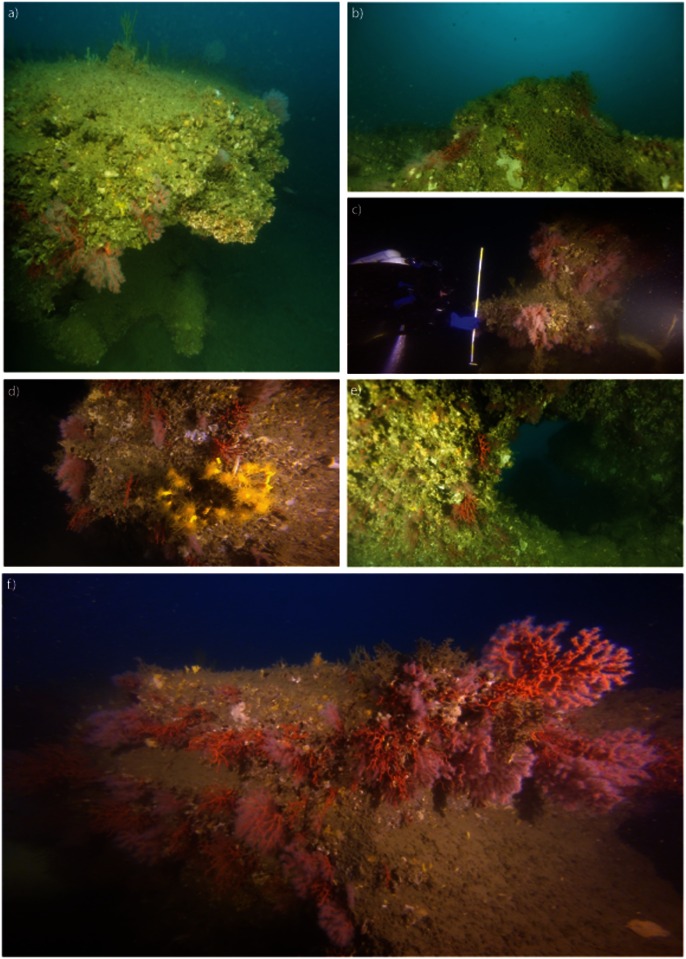
Aspects of the benthic assemblage of the red coral (Corallium rubrum) deep reefs off southern Portugal (Atlantic).Images were taken at Reefs 1–4 in Fig 1, from frames of the underwater video-transects by rebreather divers. a) Sparse red coral colonies over high relief rock with overhangs. Notice top of reef with low density of erect organisms (e.g., corals and sponges); b) Lost fishing net entangled on top of rock and corals; c) Diver measuring relief of substrate with a 1 m ruler (each yellow-white segment has 20 cm); d) Denser red coral patch and Dendrophyllia cornigera on vertical wall; e) Juveniles and small colonies in sheltered overhang; f) Higher density area over reef edges, note the larger colonies in this image; there is some distortion caused by the wide-angle and motion of the camera. Images kindly provided by the GUE Global Expedition 2014.